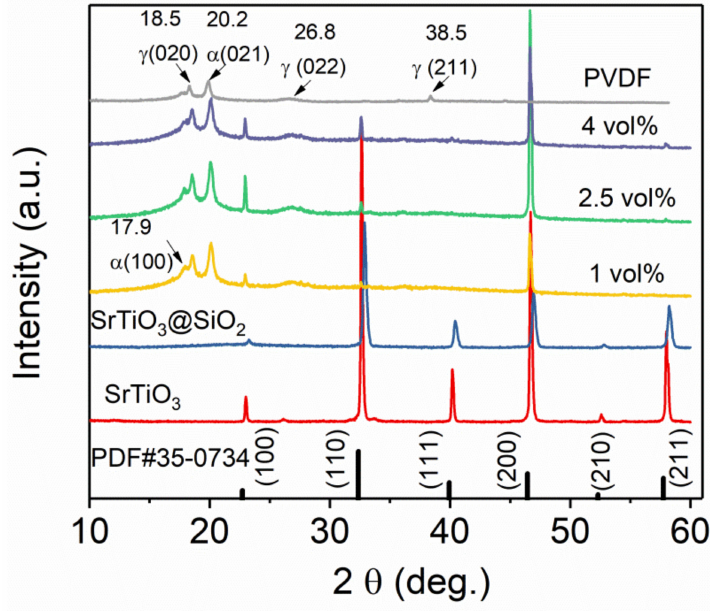
Figure 2. XRD patterns of SrTiO 3 , SrTiO 3 @SiO 2 , PVDF, and composites with SrTiO 3 @SiO 2 platelets,